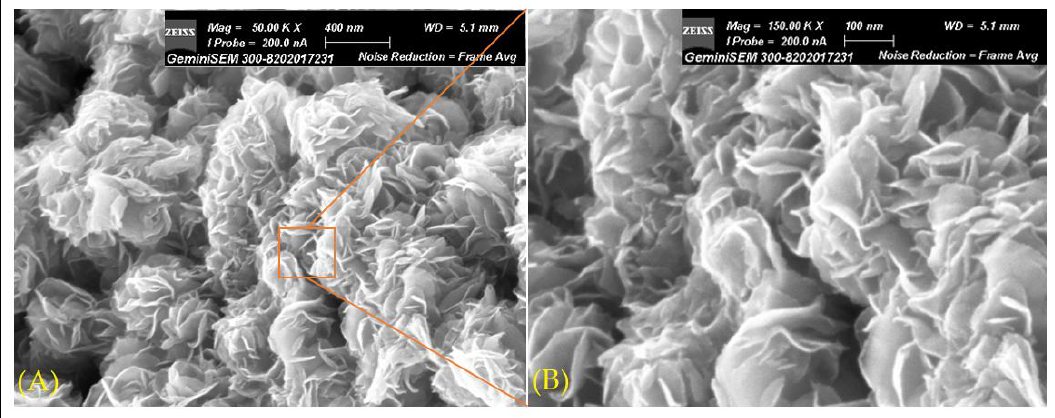
It can be seen from Figure 9 that on increasing the weight percentage of graphitic